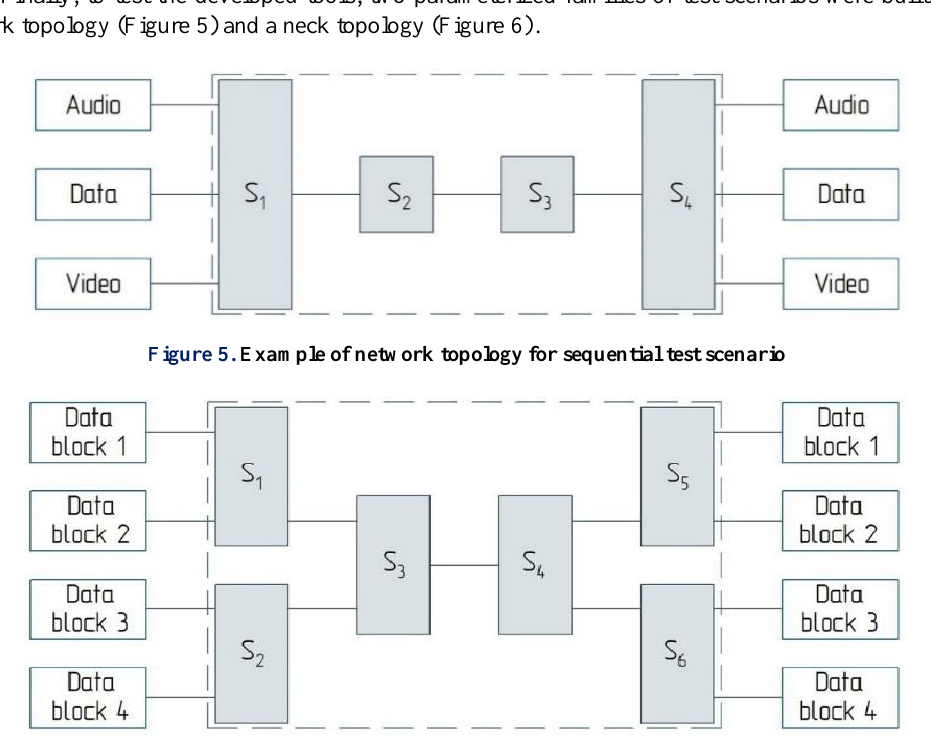
Figure 6. Example of network topology for neck test scenario